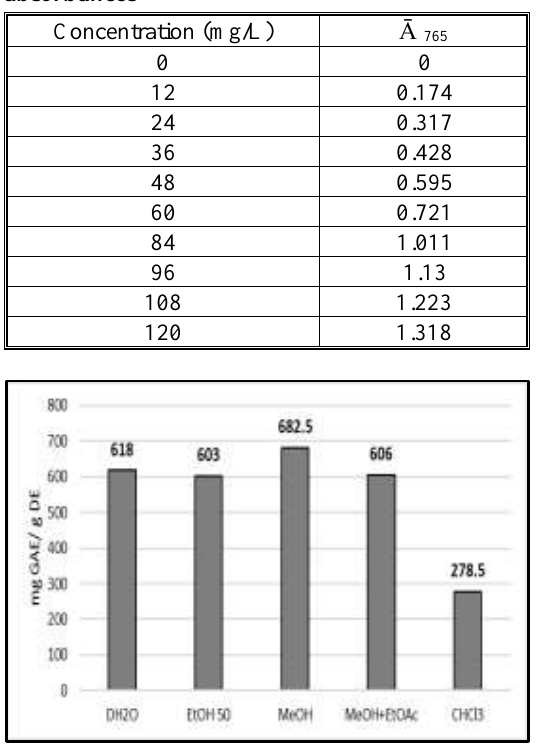
Figure 2. TPC in 1 g of the dried extracts .All results of TPC are presented as the mean of three replicates ± SD ( p < 0.05)